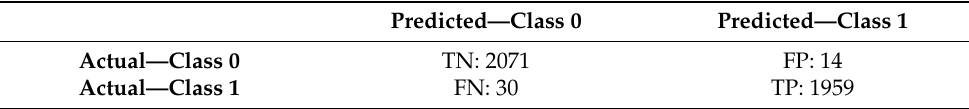
Table 3. Confusion Matrix for algae detection problem.